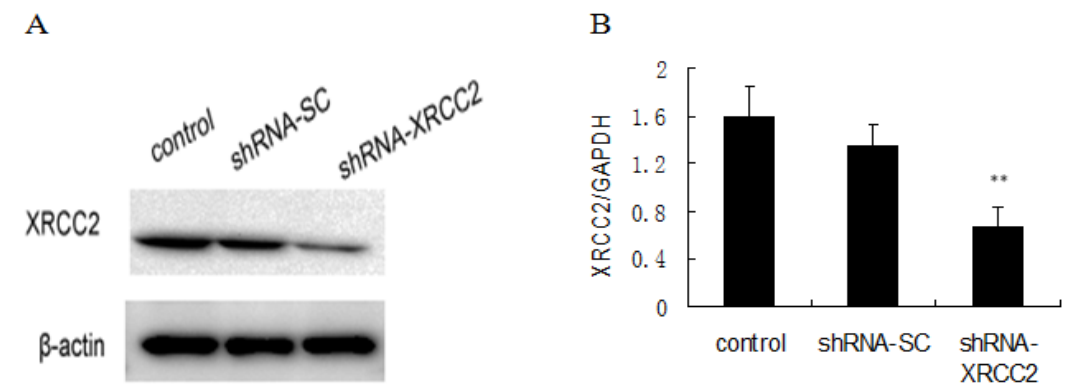
Figure 2. XRCC2 expression was suppressed by vector-based shRNA in T84 cells. ( A ) XRCC2 protein expression; and ( B ) XRCC2 mRNA expression. Cells were transfected with either shRNA-XRCC2 or shRNA-SC. Total protein and mRNA levels of XRCC2 were determined at 24 h after transfection by Western blot and quantitative real-time polymerase chain reaction (PCR) analyses, respectively. The values are presented as the mean ± SD ( n = 6). ** p < 0.01 compared with the control group.